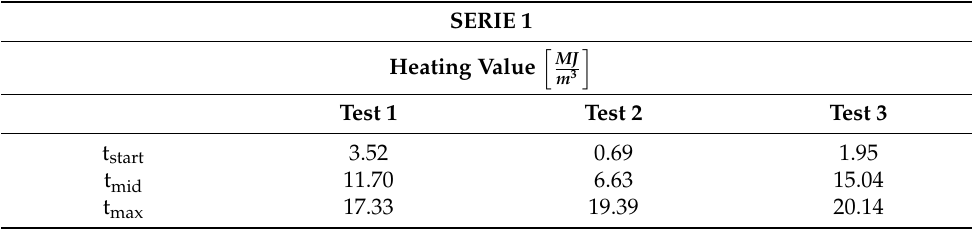
Table 1. Heating value of process gases at the start of the process, during and after achieving the maximum temperature, Serie 1 [21].